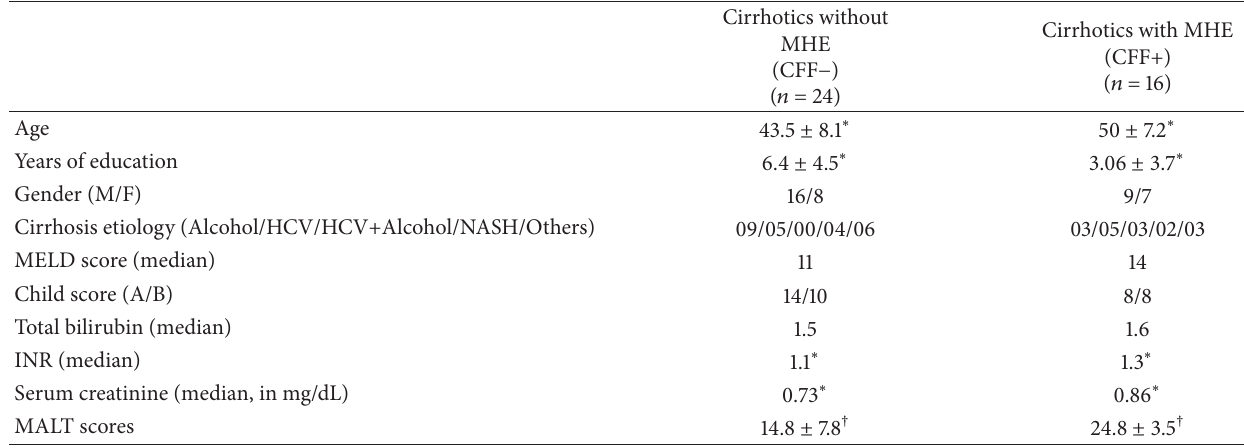
Table 4: Demographics within the cirrhosis